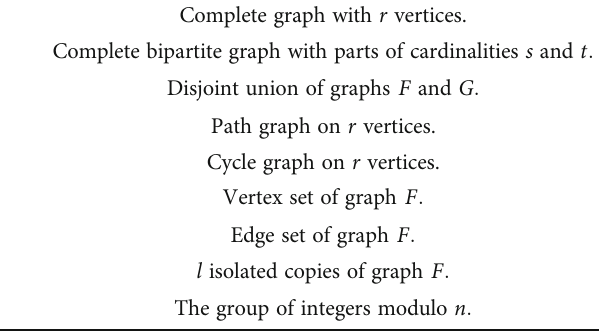
Table 1: Nomenclatures that are used in this paper. Complete graph with r vertices. Complete bipartite graph with parts of cardinalities s and t : Disjoint union of graphs F and G : Path graph on r